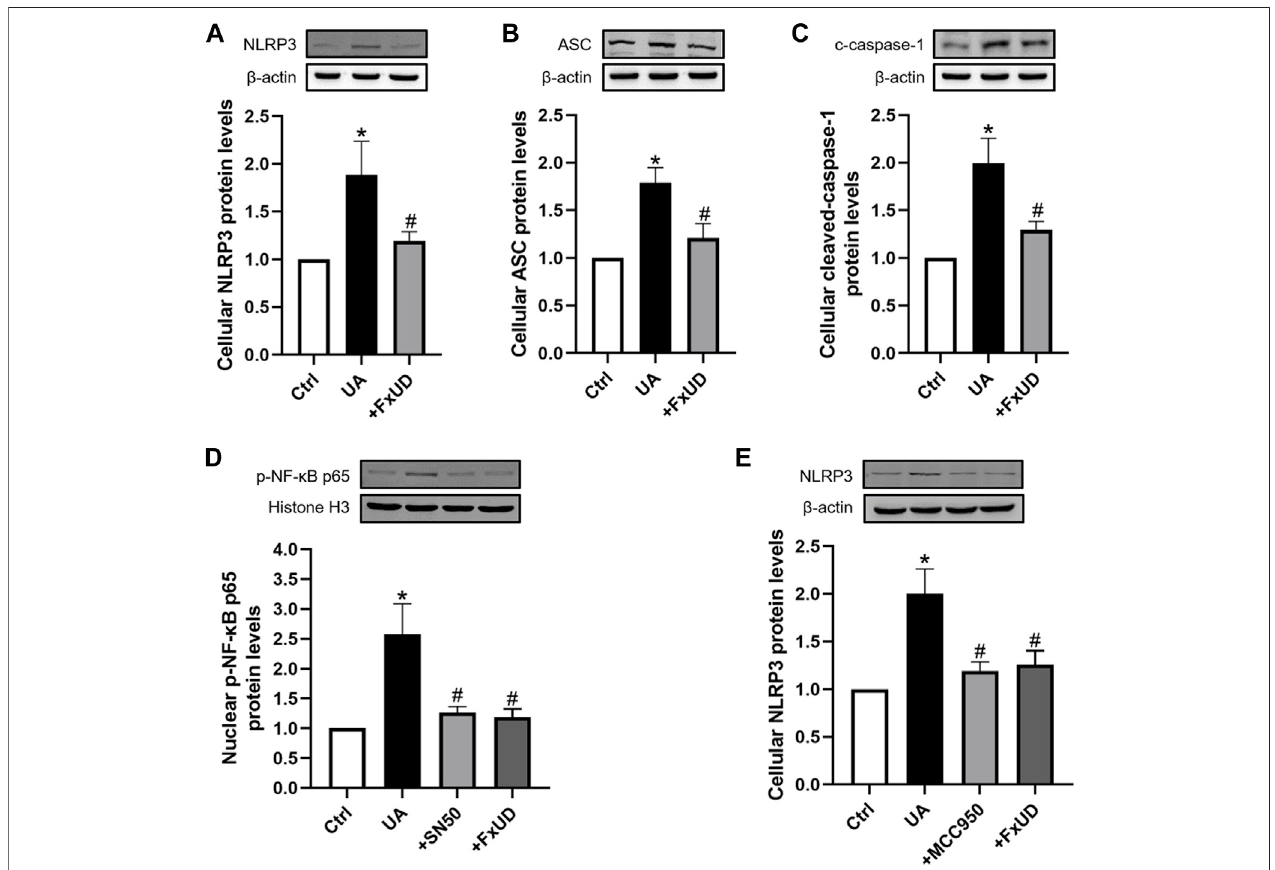
FIGURE 9 | FxUD inhibits the activation of NLRP3 in fl ammasome and NF- κ B signaling pathway in uric acid-exposed HK-2 cells. (A) NLRP3, (B) ASC, (C) c-caspase-1 protein levels in HK-2cells were measured using Westernblot analysis. The protein levels of (D) p-NF- κ B and (E) NLRP3 in HK-2 cellsexposed toUA after treatment with SN50 or MCC950. Values are expressed as the means ± SD ( n (cid:1) 4). * p < 0.05 vs. Ctrl, # p < 0.05 vs. UA.